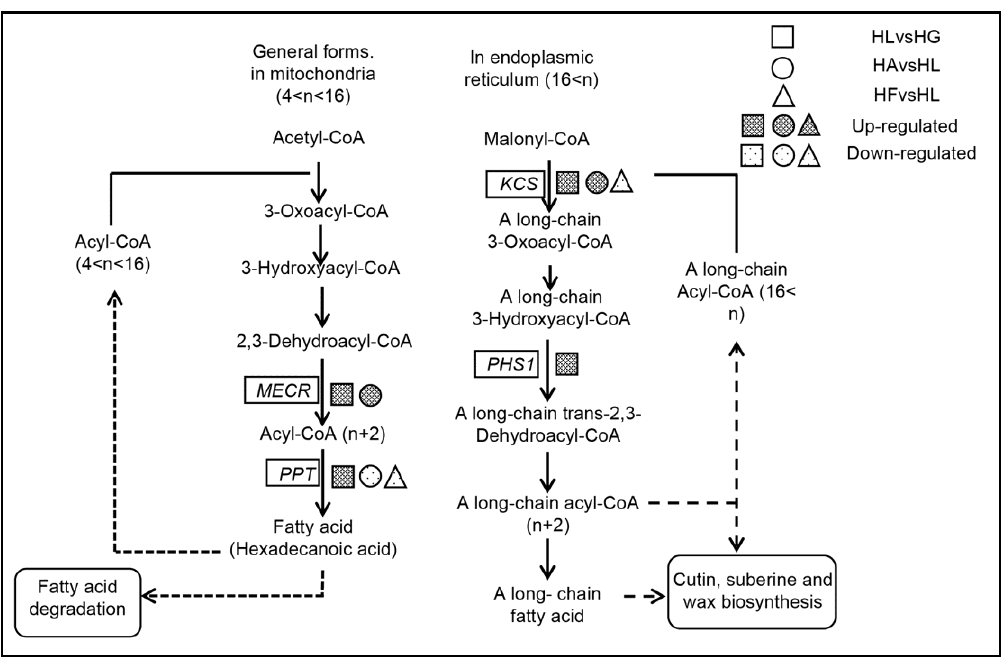
Figure 8. The pathways for fatty acid elongation. The boxed genes are the differentially expressed genes related to the pathway, “ n ” indicates the number of carbon atoms in the fatty acid chain. MECR : mitochondrial trans-2-enoyl-CoA reductase; PPT : palmitoyl-protein thioesterase; KCS : 3-ketoacyl-CoA synthase; PHS1 : very-long-chain (3R)-3-hydroxyacyl-CoA dehydratase.